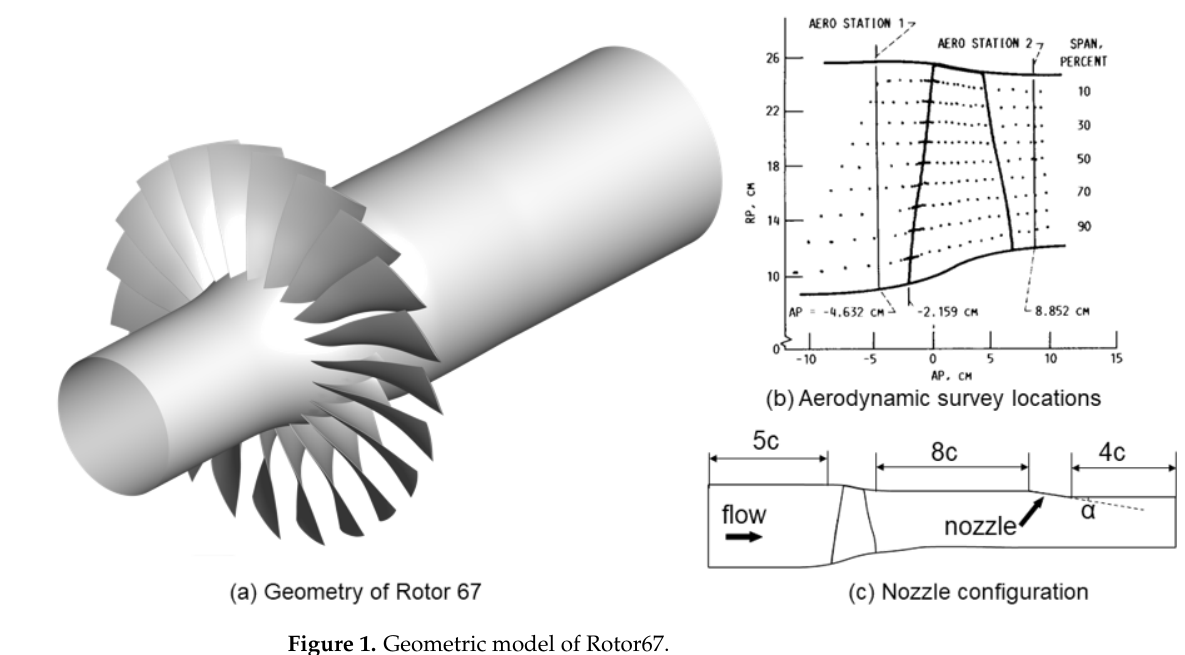
Figure 1. Geometric model of Rotor67.